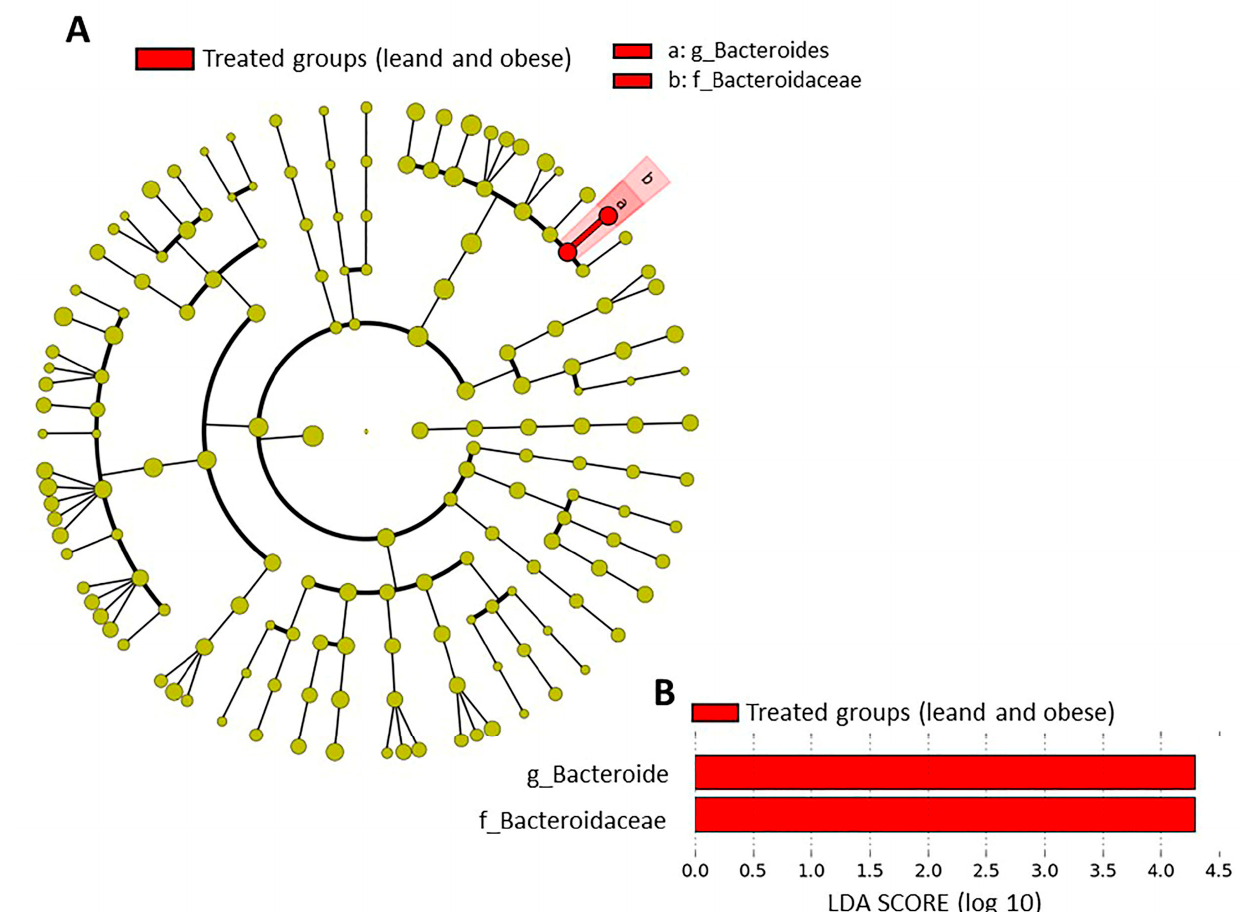
Figure 4. Taxonomic differences in fecal microbiota between groups. Taxa enriched in treated groups (lean and obese) have a positive score (red) ( A ). Only taxa meeting an LDA significance threshold >2 are shown ( B ).